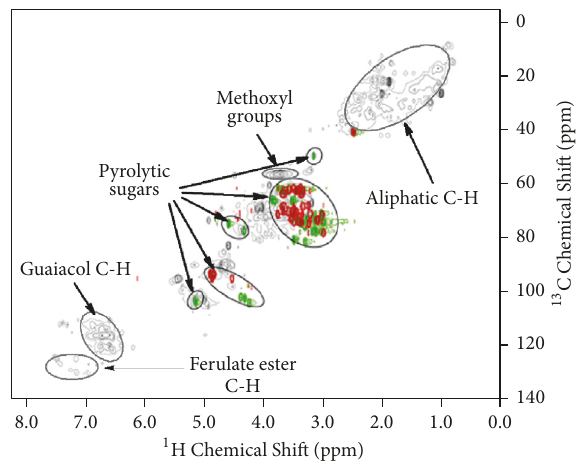
Figure 8: Typical assignments of biooil and various sugar standards in 2D 1 H- 13 C HSQC spectra. Gray: biooil; red: sugar monomers including glucose, galactose, mannose, xylose, and arabinose; green: anhydrosugarsincludinglevoglucosan,cellobiosan,andcellotriosan